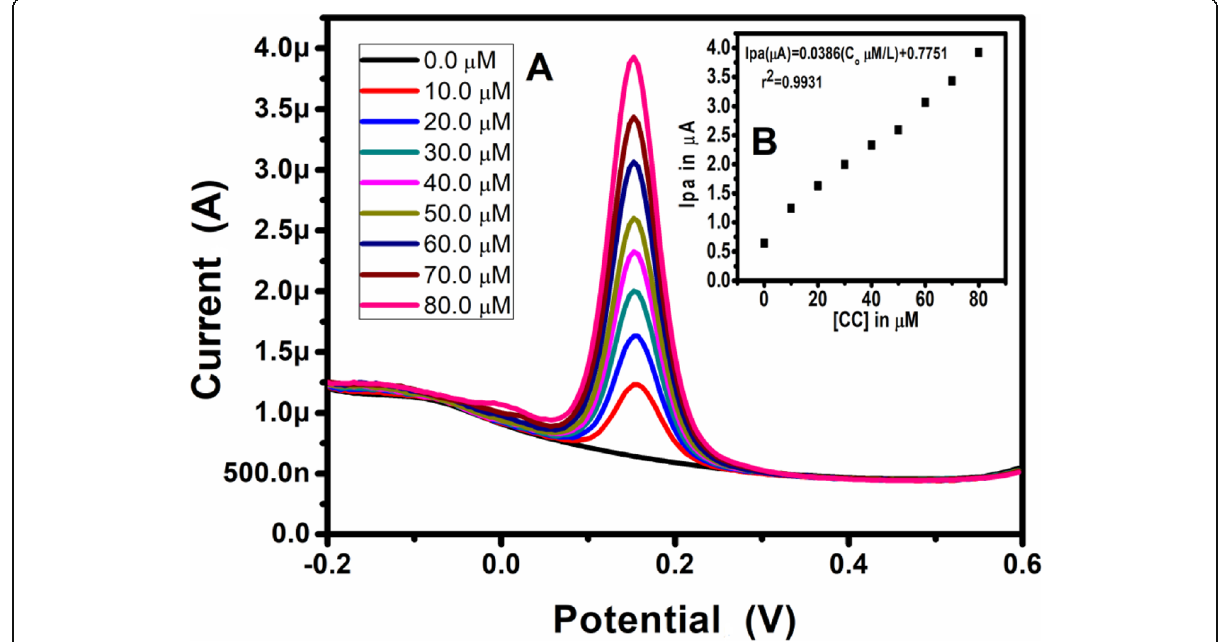
Fig. 7 a DPVs of ALR/GCE with different concentrations of CC (0 to 80.0 μ M). b Linear plot of Ipa versus concentration of CC